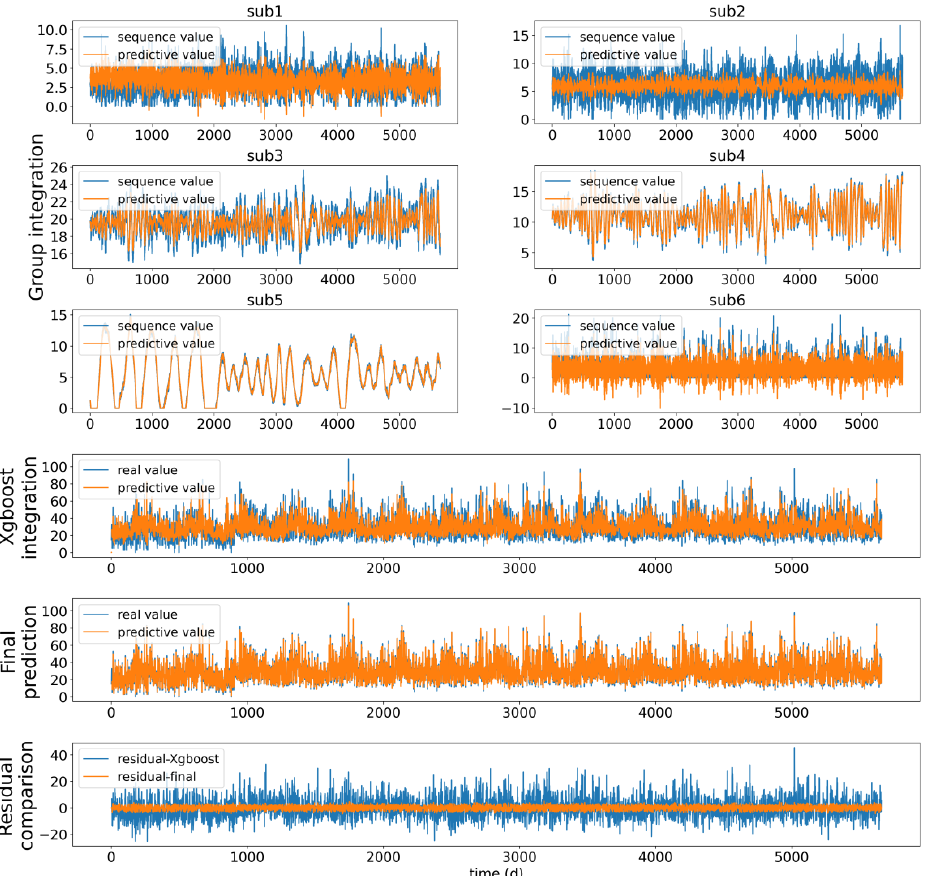
Figure 6. The first six subfigures are the point prediction results of subseries. The seventh subfigure titled “Xgboost integration” shows the integrated results. The eighth subfigure represents the final point prediction results which are generated based on the Xgboost integration and error correction strategy. The last subfigure is the residual comparison between the model with error correction strategy and the model without it. All the experimental results here used data in case 1.